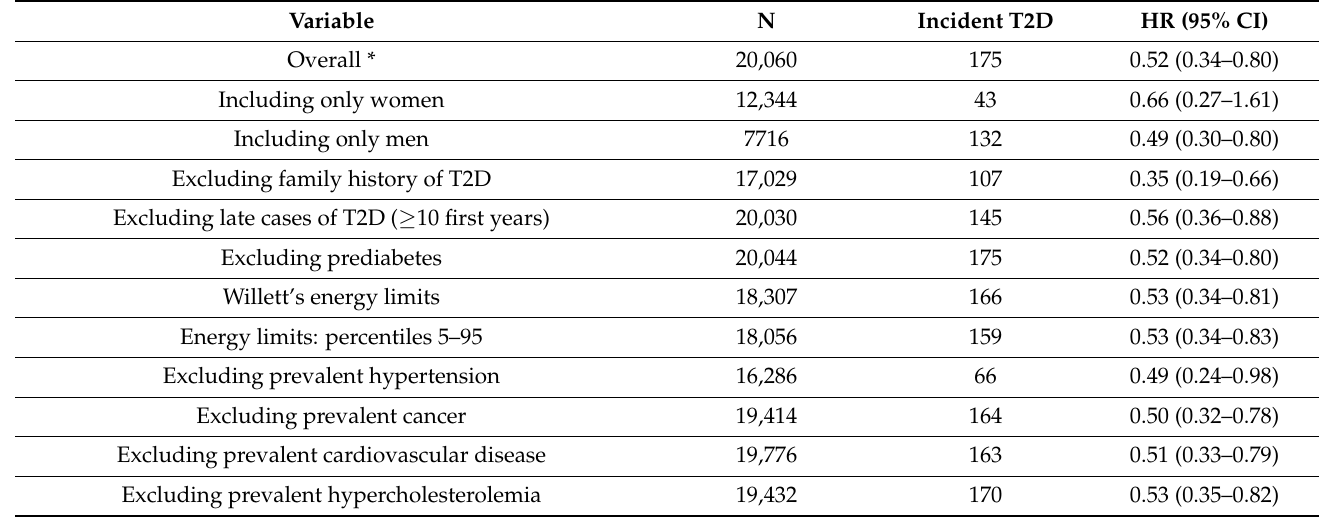
Table 3. Sensitivity analysis for incident T2D associated with the substitution of one hour of sitting for one hour of vigorous physical